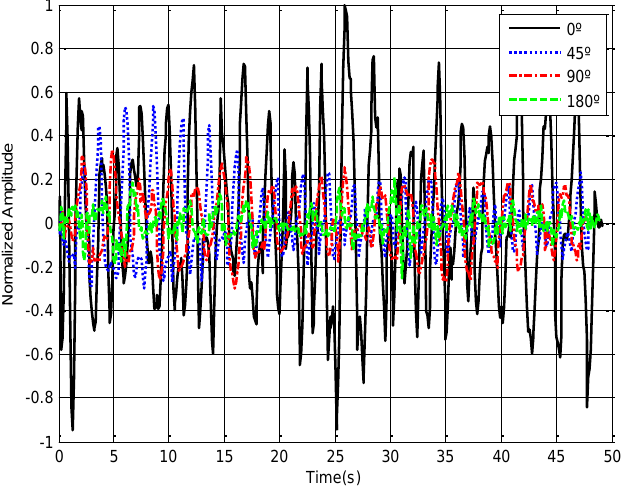
Figure 7. Dependence of breathing signal as function of orientation at a distance of 1